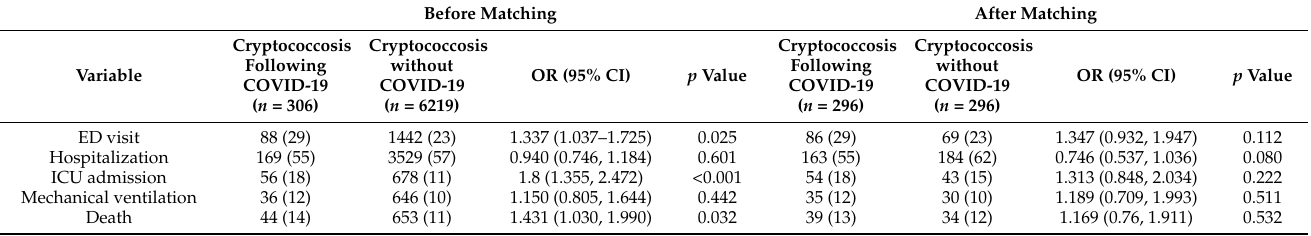
Table 2. Differences in outcomes among patients with cryptococcosis following COVID-19 compared to non-COVID-19 controls with